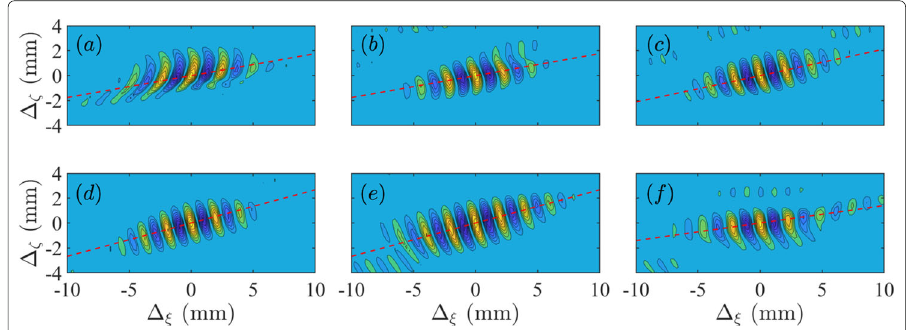
(cid:3) (cid:2) (cid:7) ξ , (cid:7) ζ ,0 Fig. 15 C pp for high-frequency wall pressure at probe points in Group 2. Contour levels are the same as in Fig. 13. The dashed lines have slopes arctan